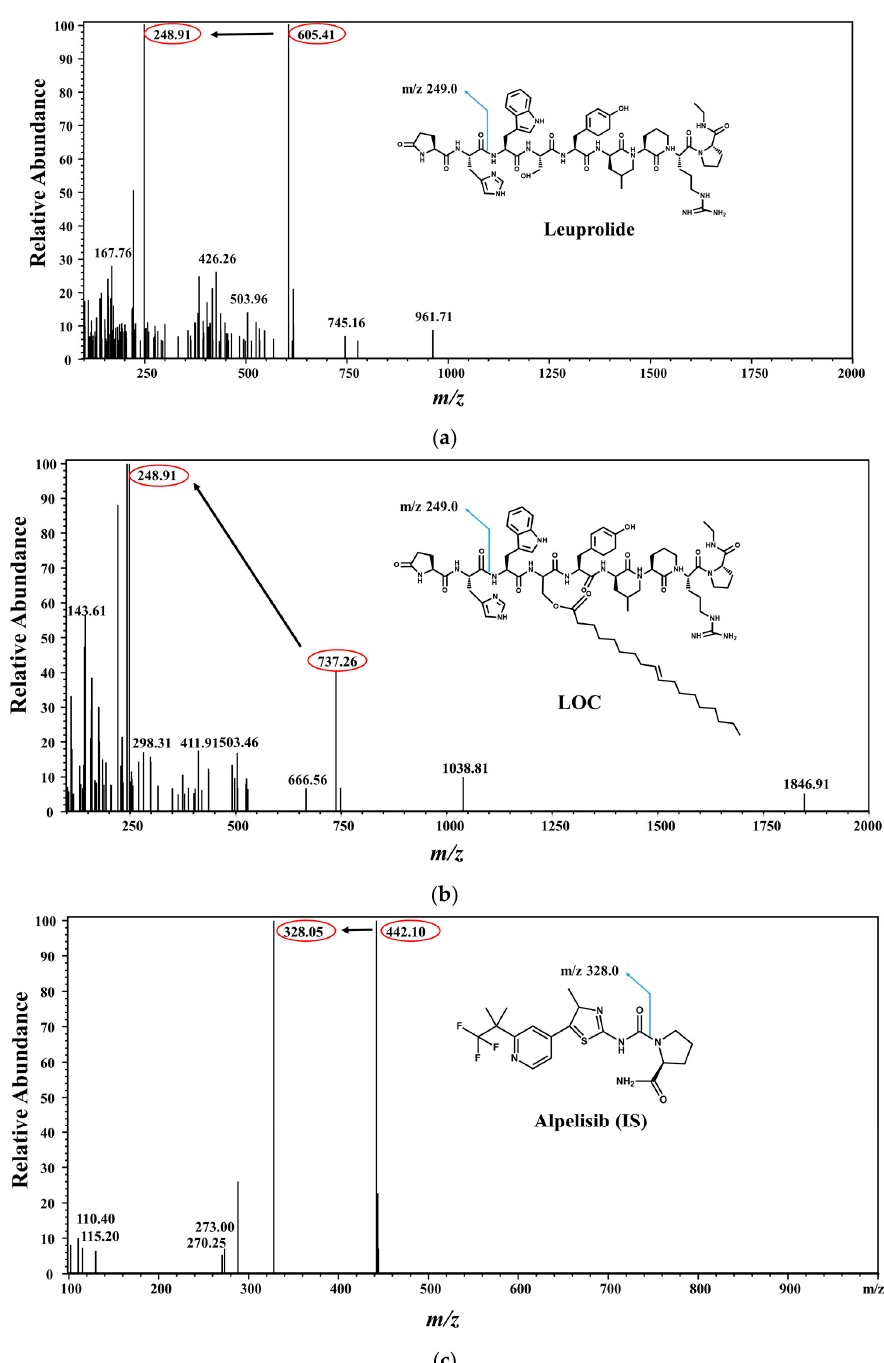
Figure 1. Chemical structures of leuprolide, leuprolide-oleic acid conjugate (LOC), and alpelisib (IS). Mass-product ion-scan spectra and chromatograms of ( a ) leuprolide, ( b ) LOC, and ( c ) IS.